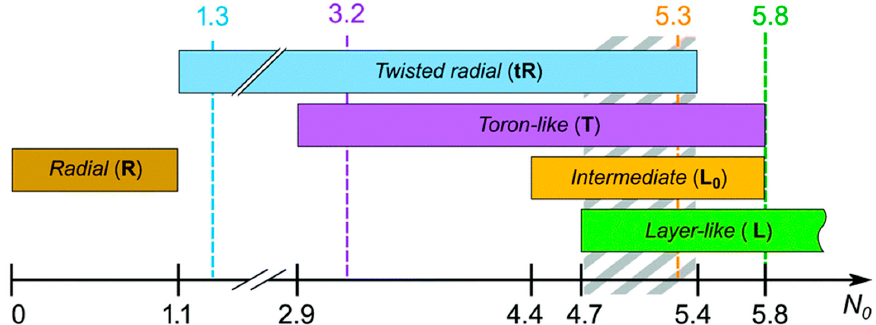
Figure 9. Diagram of the observed textures at various droplet sizes as a function of the relative helicity parameter N 0 . Reprinted with permission from ref. [37]. Copyright 2005, the Royal Society of Chemistry.